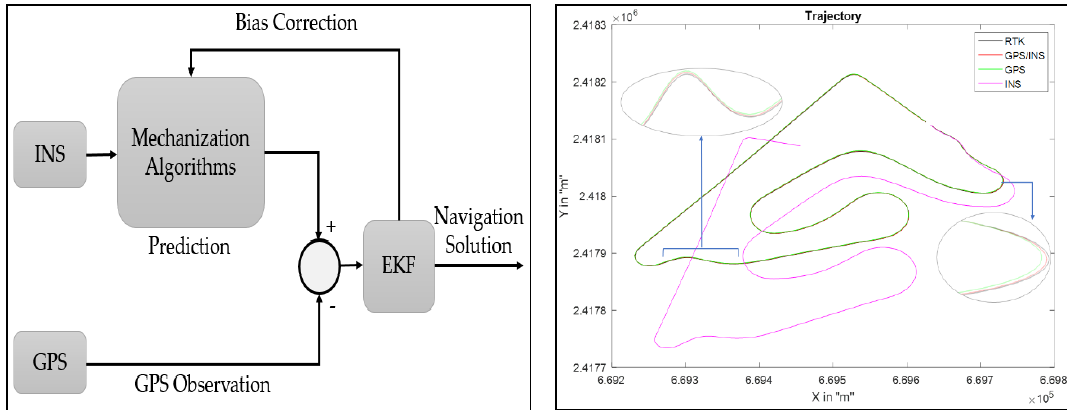
Figure 11. Loose coupling integration scheme (INS/GPS).